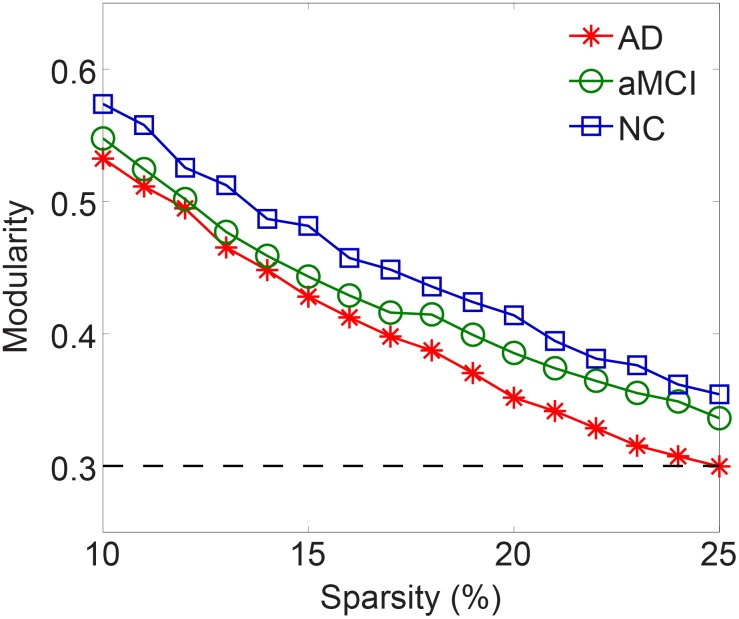
Modularity Q of the functional brain networks for AD, aMCI and NC groups with respect to sparsity.The black dashed line indicates the threshold for the nonrandom community structure. Note that only the modularity of AD group is less than 0.3 for S = 25%.